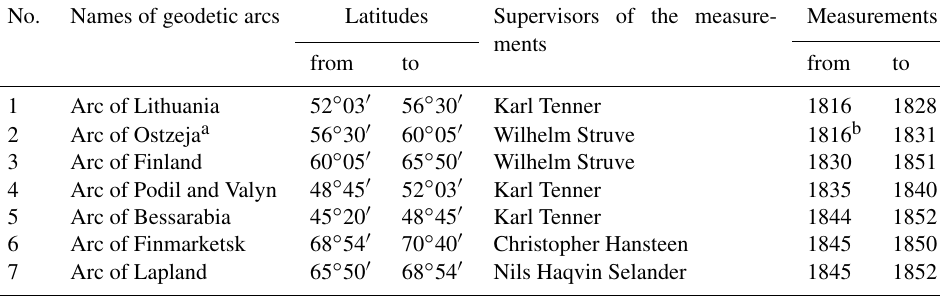
Table 2. Measurements of segments of the Struve Geodetic Arc. Supervisor Measured Lengths of arc segments Latitudes measured Triangles Base lines from to Karl Tenner 125 5 11 ◦ 10 (cid:48)